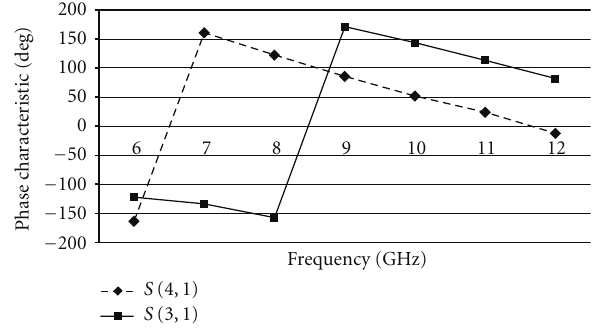
Figure 6: Phase characteristic of nonuniform branch line coupler.